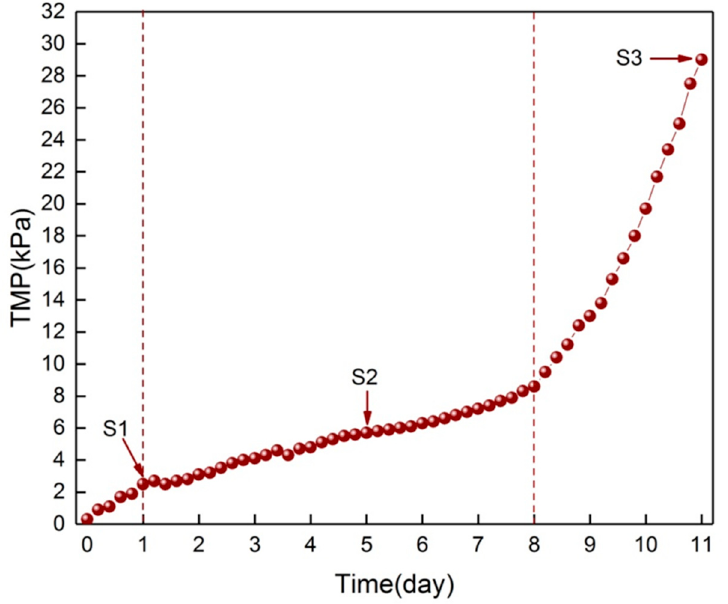
Figure 2. Change of the TMP during M3 operation. S1, S2, and S3 are samples scraped from M1, M2, and M3, respectively.